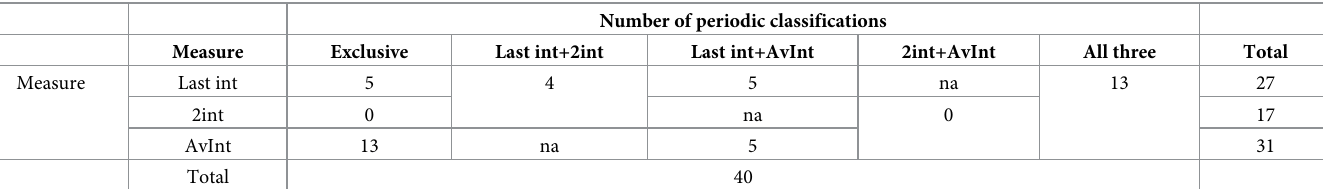
Table 4. Number of multi-interval Q+A pairs classed as periodic, by type of measure.